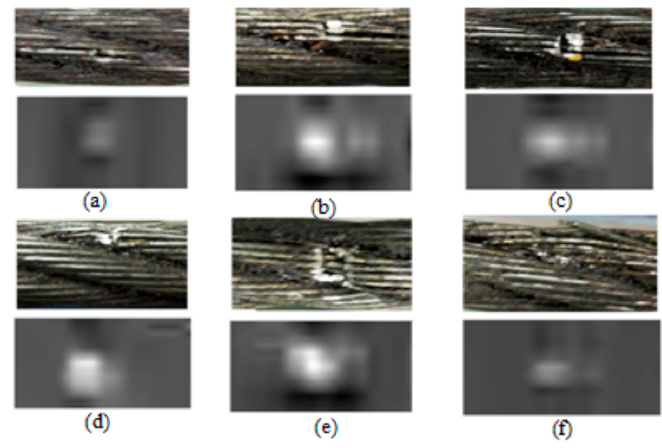
Figure 10. Images of broken wires (top) and high-resolution gray-level RMF images of the corresponding broken wires (bottom): ( a ) one broken wire; ( b ) two broken wires; ( c ) three broken wires; ( d ) five broken wires; ( e ) seven broken wires; ( f ) warping two wires.